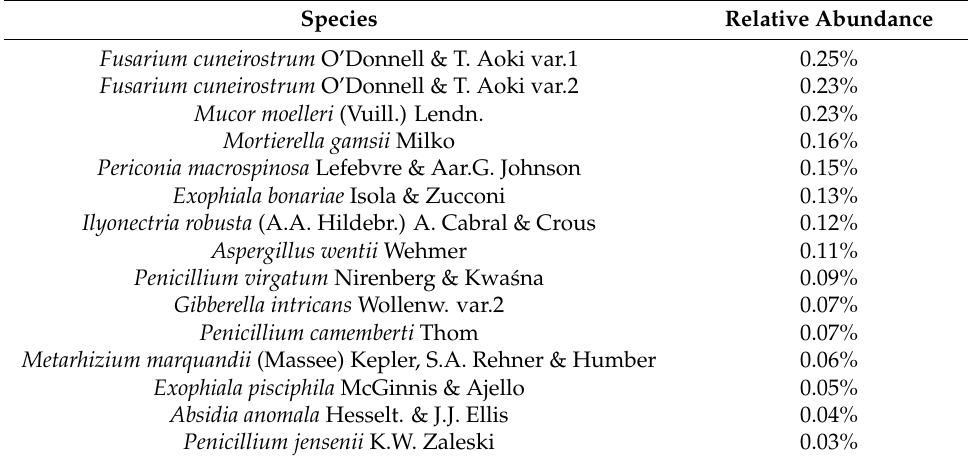
Table 4. List of OTUs with a significantly higher abundance in SR plots compared with NC plots (differential expression analysis based on the negative binomial distribution). The p-values shown are adjusted by false discovery rate (FDR, cut-off at 0.01).